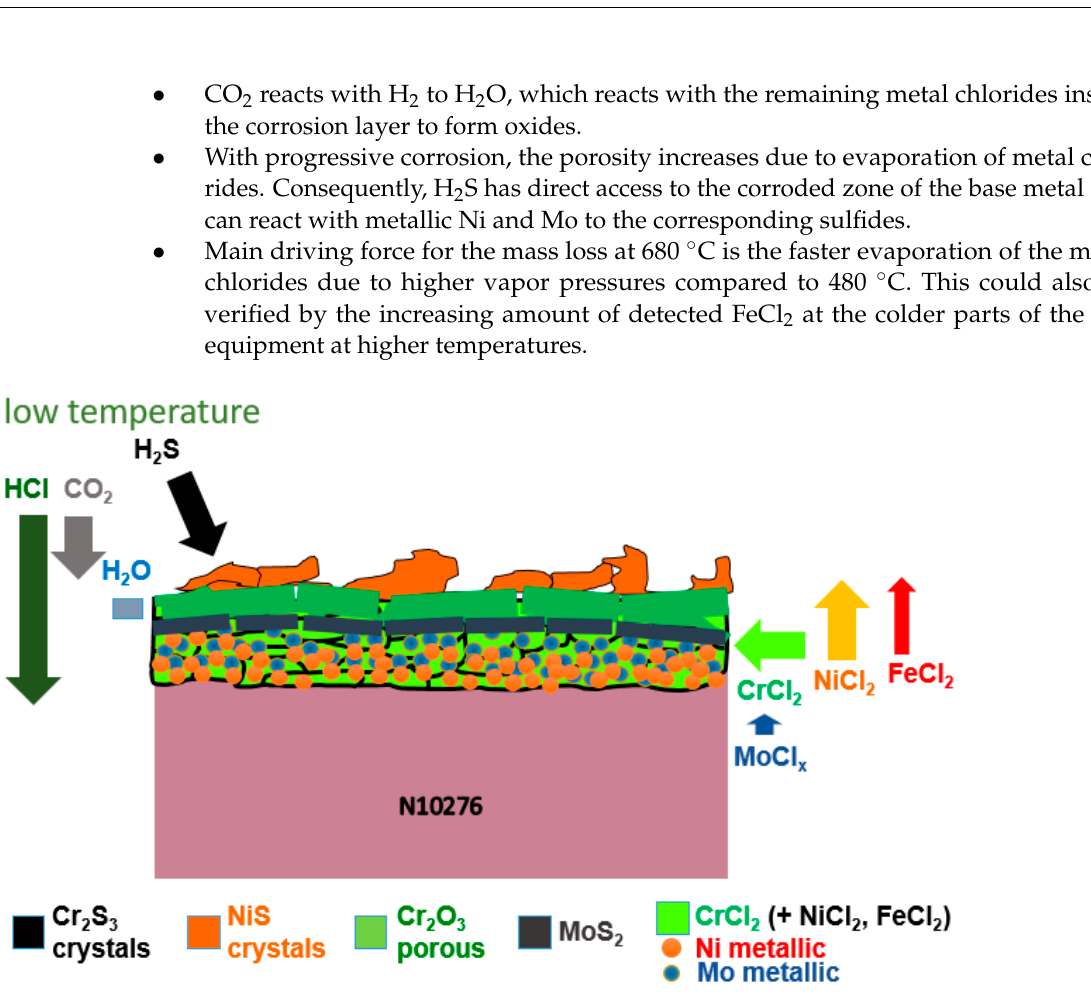
Figure 8. Schematic illustration of the proposed corrosion mechanism for N10276 at 480 °C.